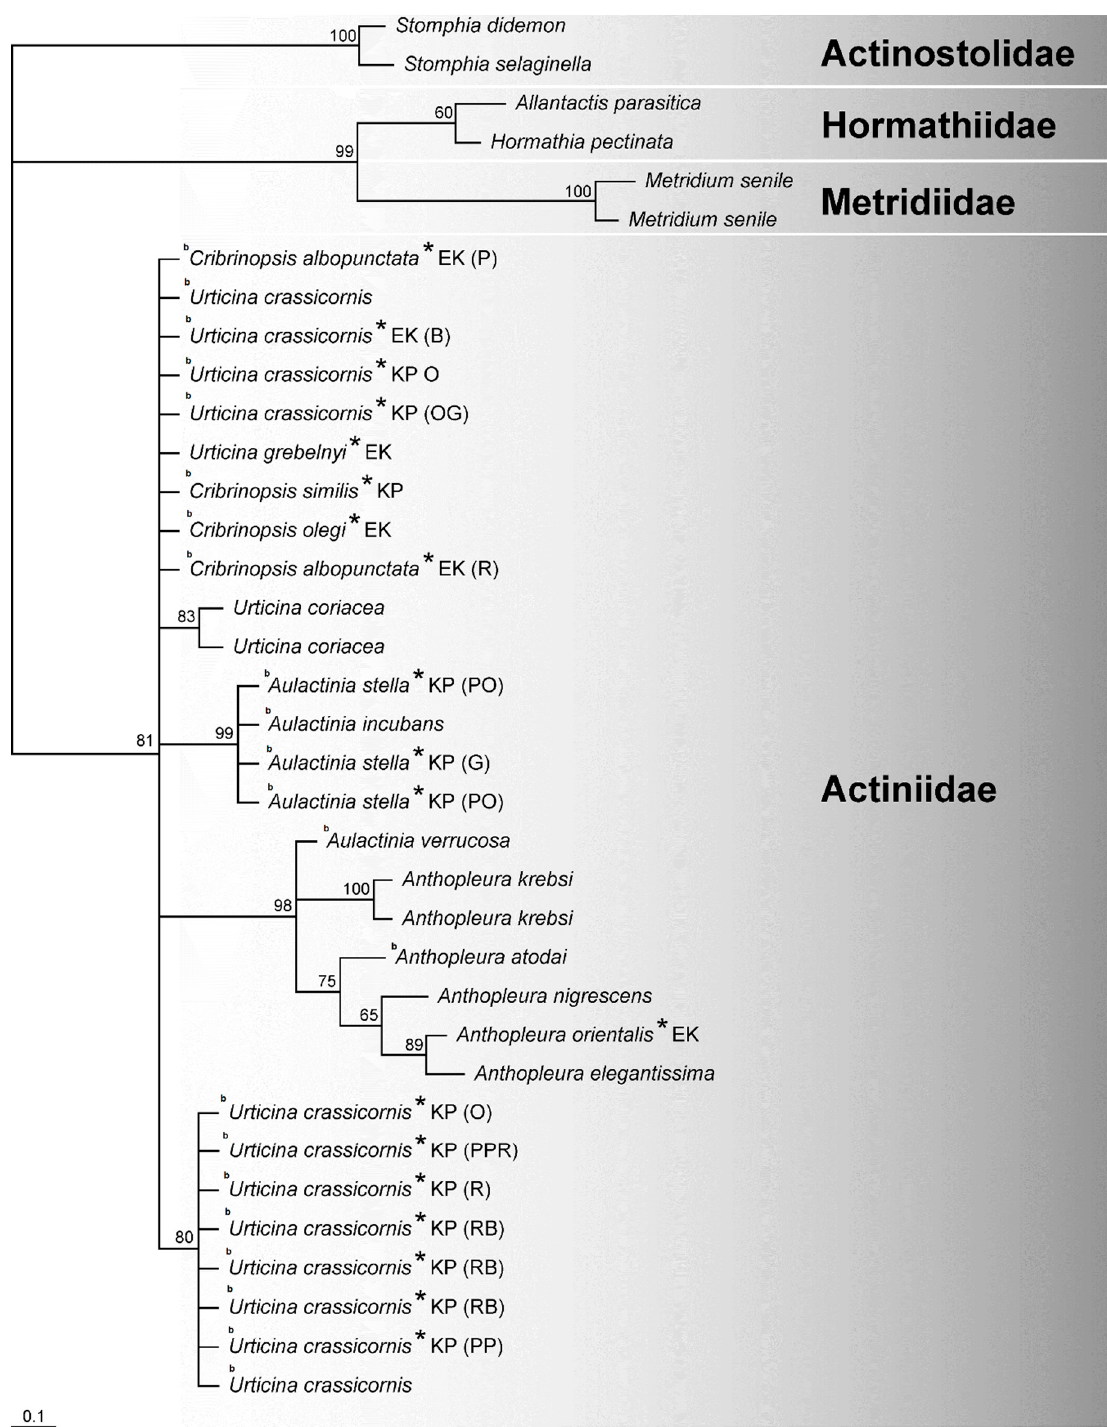
Figure 3. Neighbor-joining tree from 16S rDNA sequences. The sequences with the numbers were taken from GenBank. Letters next to the species name indicate the collection site of species reported in this study (KP—Kola Peninsula, EK—East Kamchatka). The color patterns for specimens of Urticina crassicornis, Cribrinopsis similis, Cribrinopsis albopunctata, and Aulactinia stella are given in parentheses (PPR—pale pink with red stripes, PP—pale pink, RB—red–blue blotched, PO— pale orange, OG—orange with gray tentacles, O—orange, R—red, G—gray, B—beige). Numbers at nodes are posterior probability values. The letter b indicates the species with the brooding strategy.